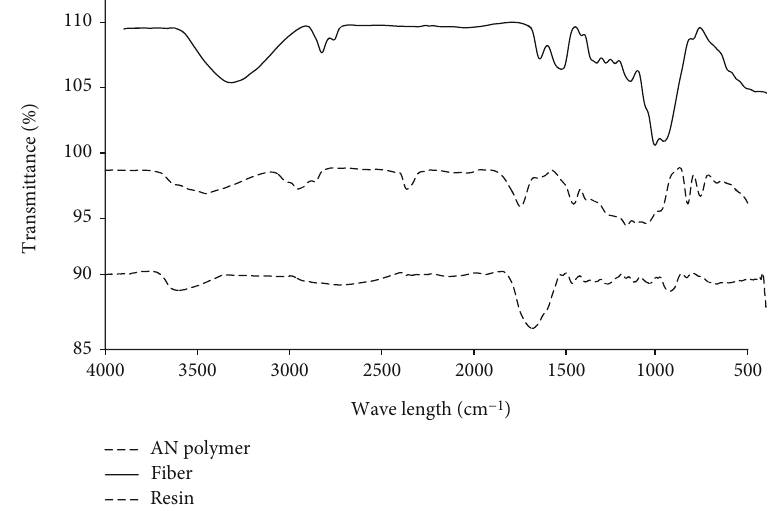
Figure 8: FTIR DPWF fi ber ( ─ ), AN-g-DPWF fi ber (- -), and resin containing amidoxime groups ( ···